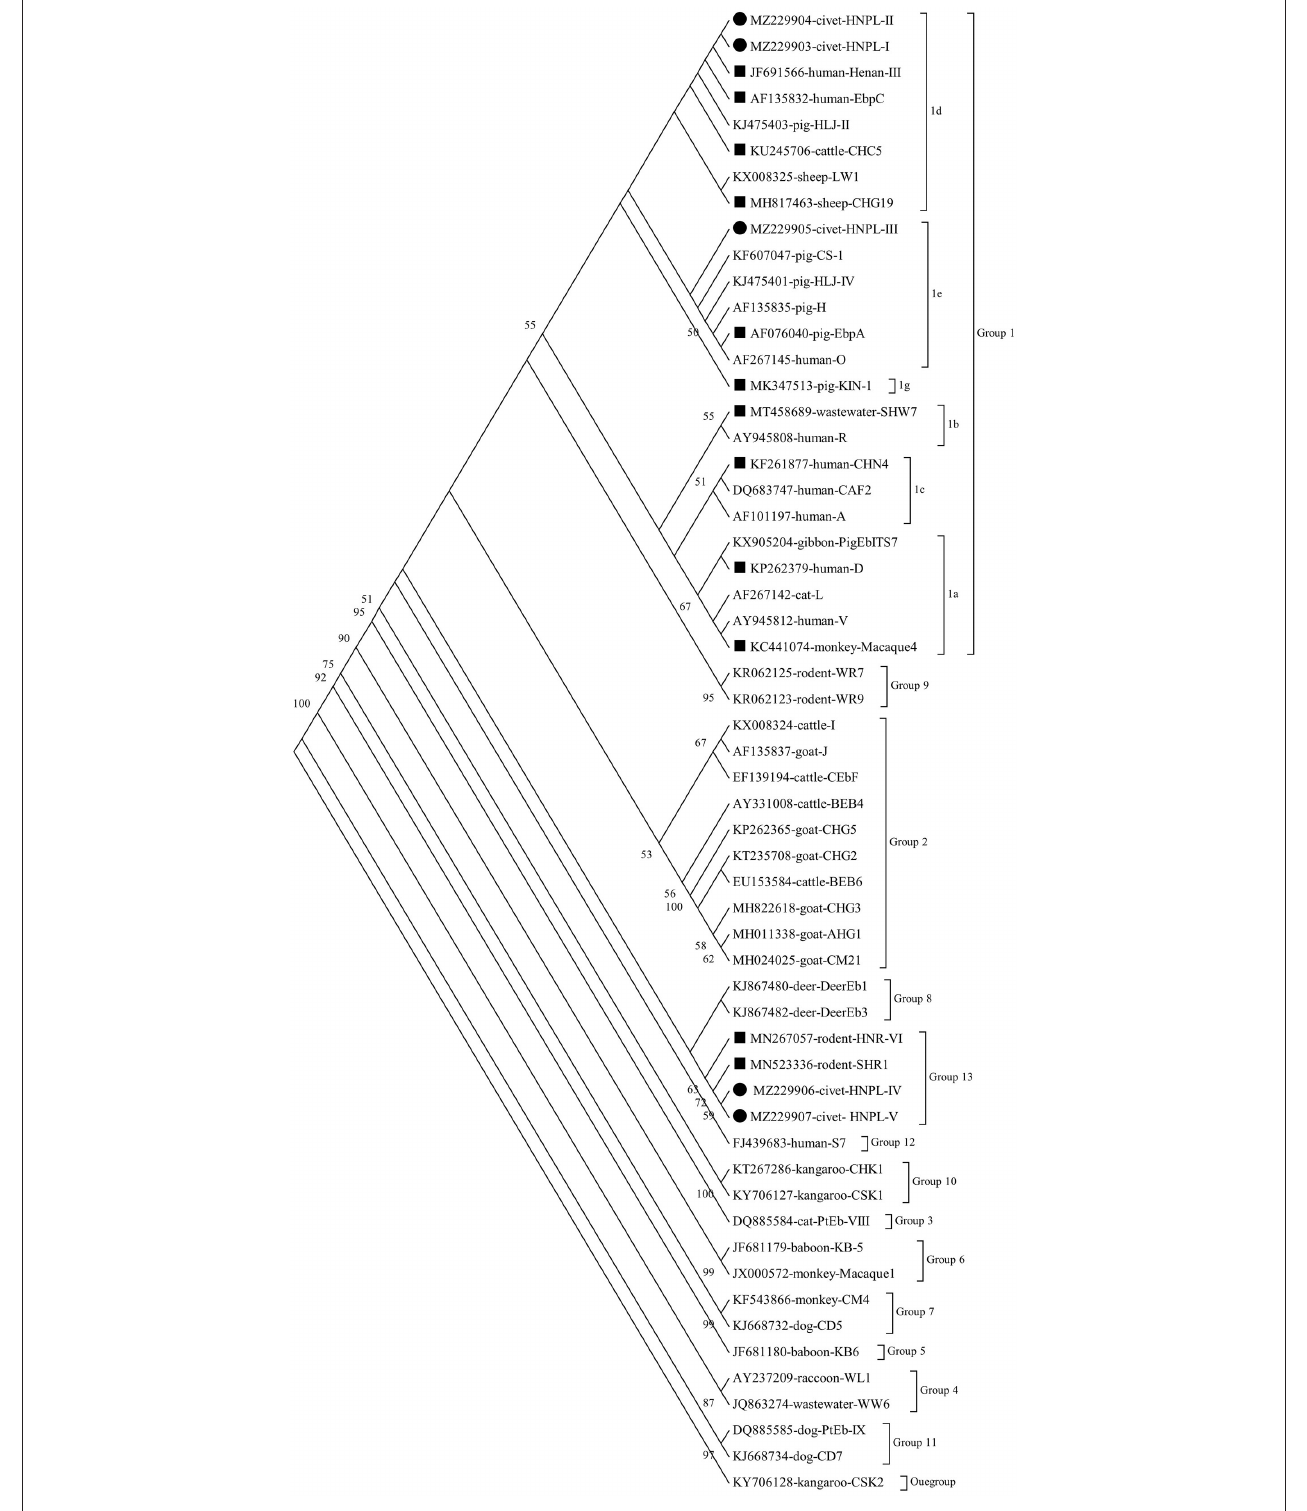
FIGURE 2 | Phylogenetic relationship of the Enterocytozoon bieneusi genotypes. A neighbor joining (NJ) tree was done to infer the relationships of the E. bieneusi genotypes identified here and the known ones (GenBank). The numbers on the branches represent % bootstrap values for 1,000 replicates; the values generated > 50% are shown beside the nodes. The host origin, accession number, and genotype designation were used to identify individual sequences. The filled squares and circles represent the known and novel genotypes identified here, respectively.